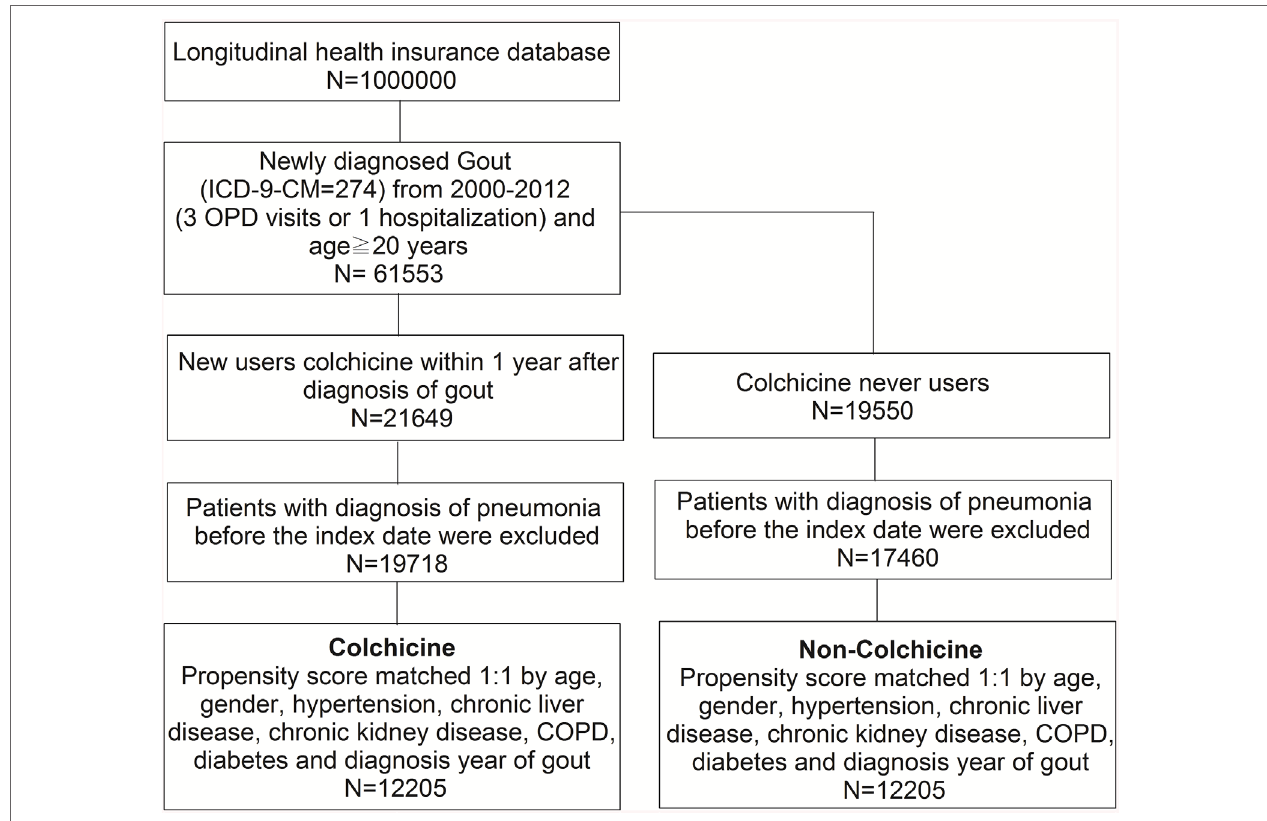
FIGURE 1 | The study population selection